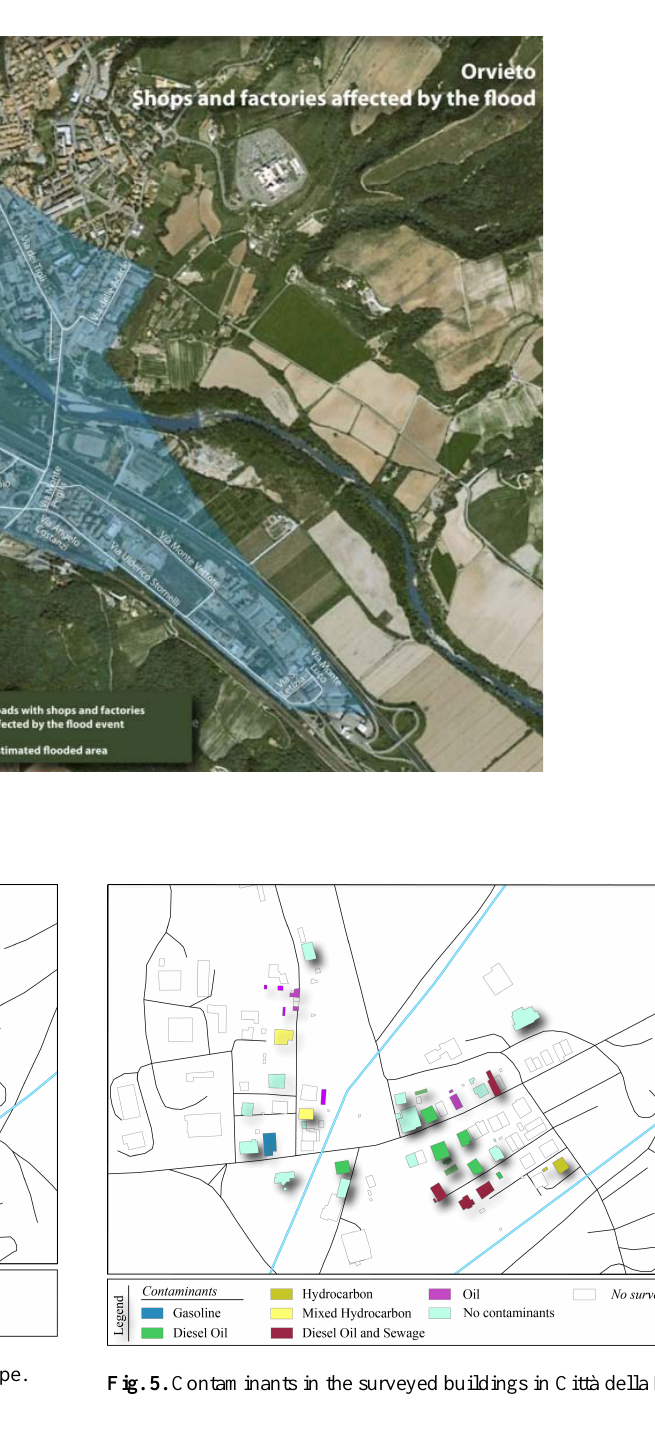
Figure 4. Surveyed buildings in Città della Pieve by building type 4 5 6 7